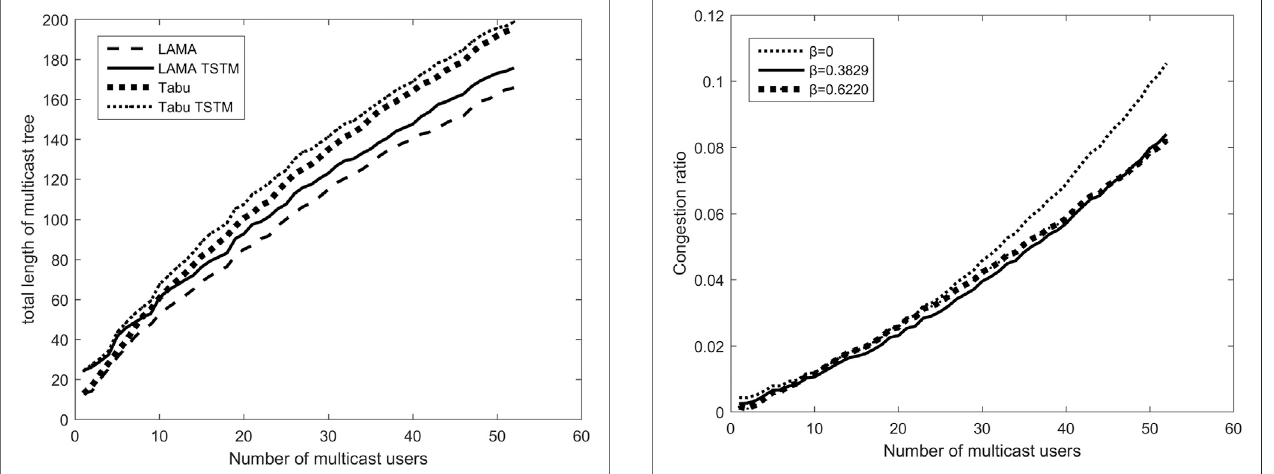
FIGURE 11 | The congestion ratio of the system with different load factor β